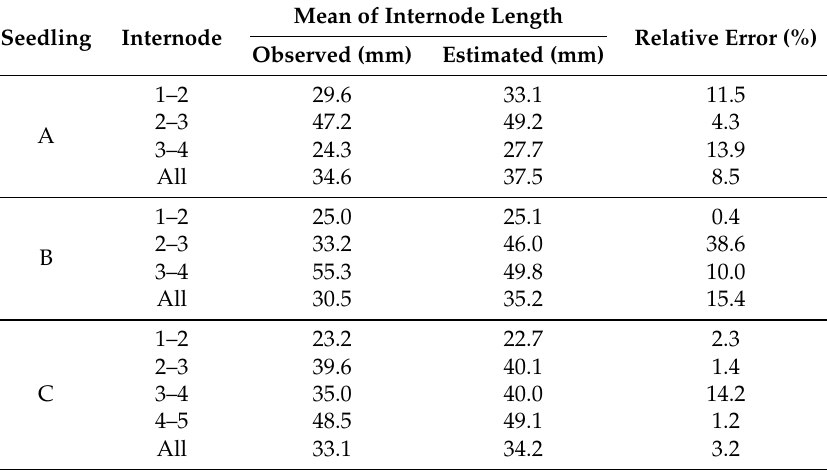
Table 4. Result of internode length